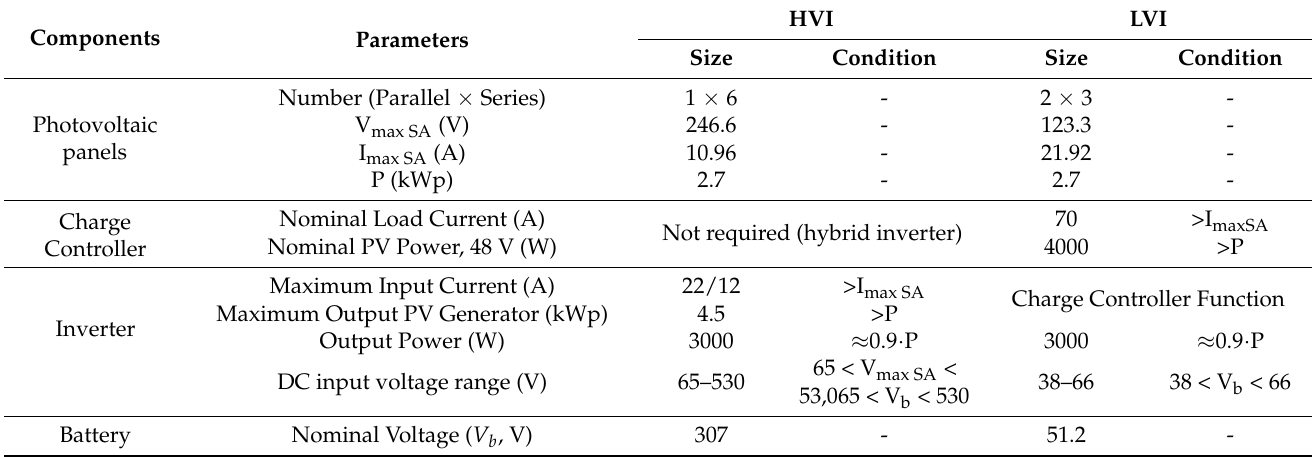
Table 3. Prototype